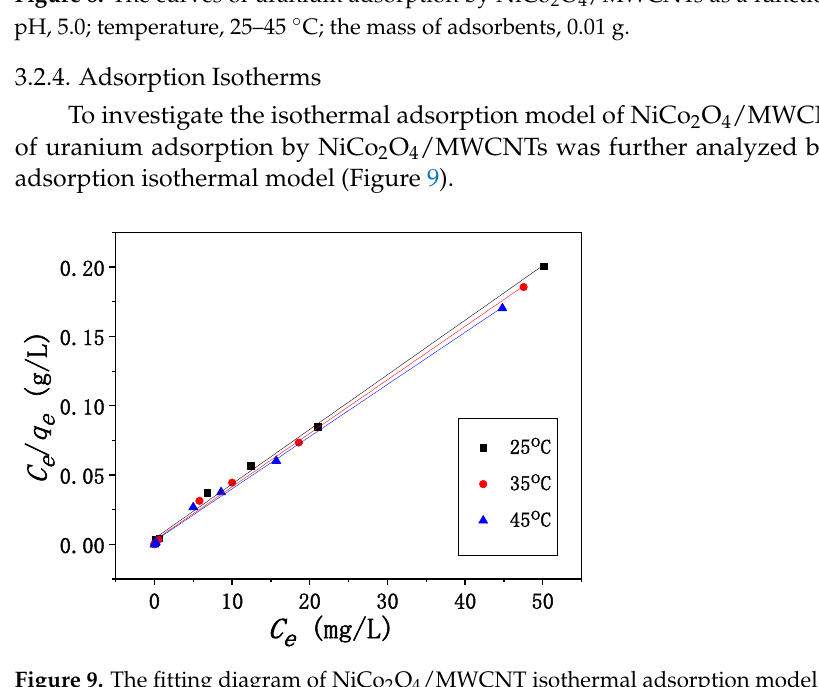
Table 2. Langmuir constants of NiCo 2 O 4 /MWCNTs.